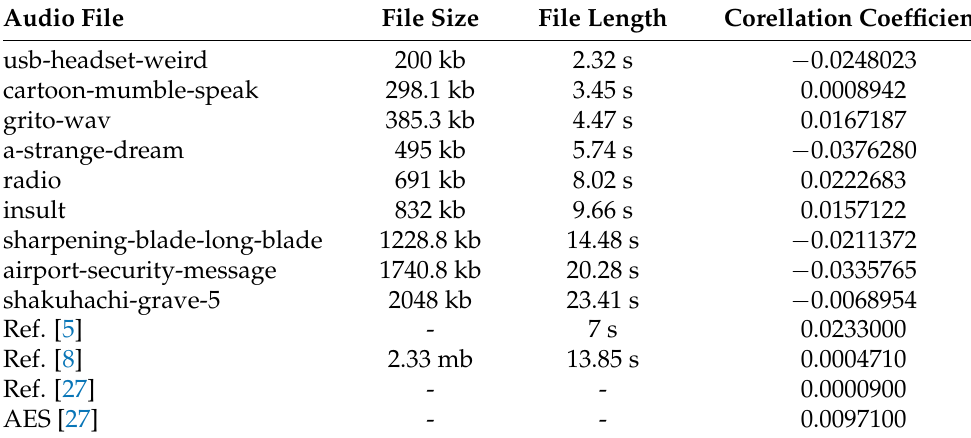
Table 1. Correlation between plain and encrypted audio